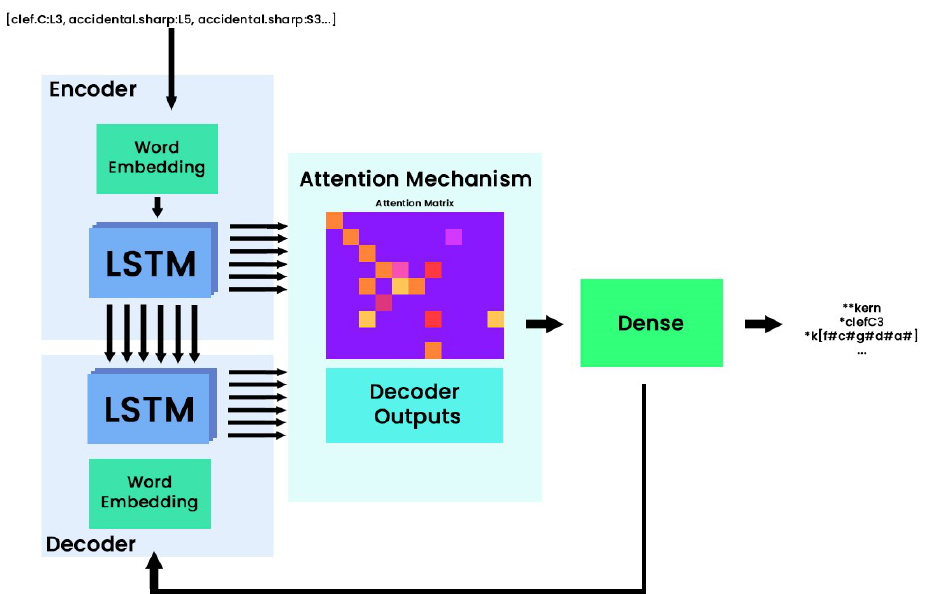
Figure 3. Proposed neural architecture for the Seq2Seq with attention mechanisms model. In this schema, the LSTM (long short-term memory layers) boxes represent the recurrent layers implemented in the encoding, and decoding steps and the dense box represents the last linear layer which classifies the next token in the target sequence. The output of this layer is then propagated to the decoder in order to provide this new information to predict the next token in the target